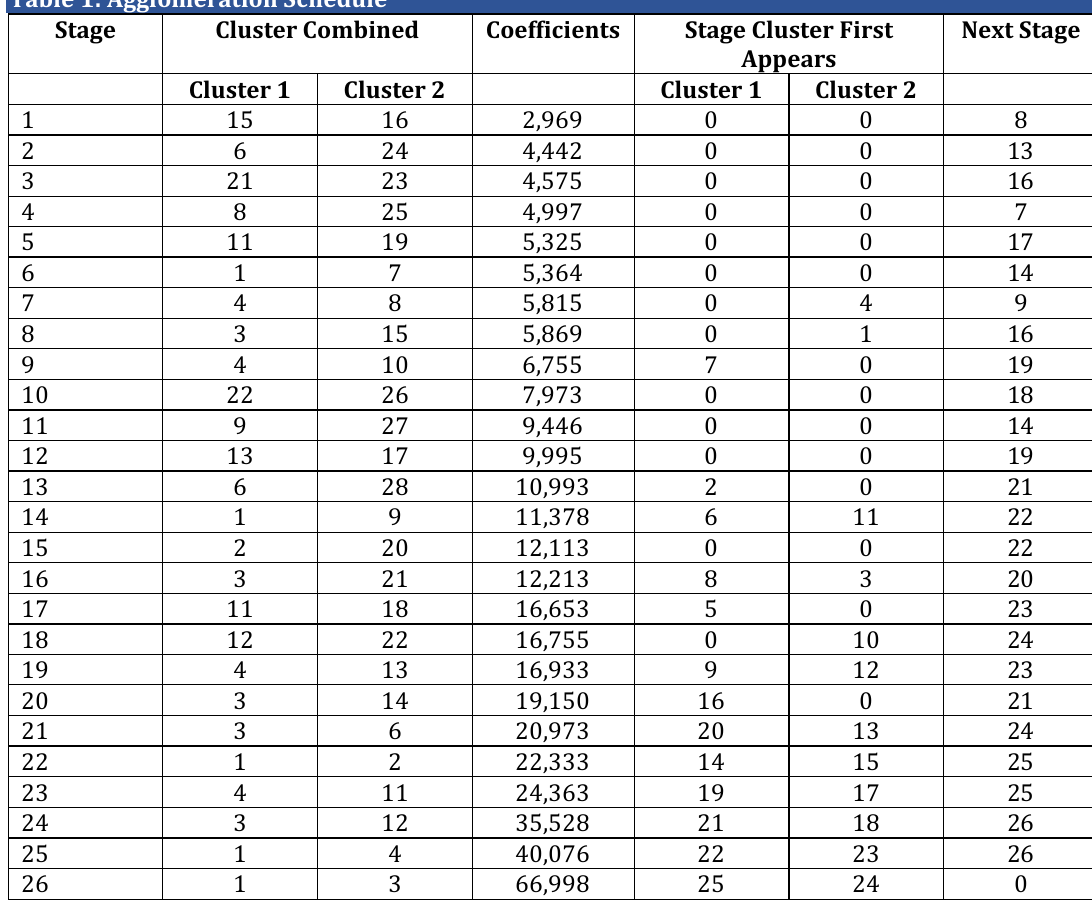
Table 1: Agglomeration